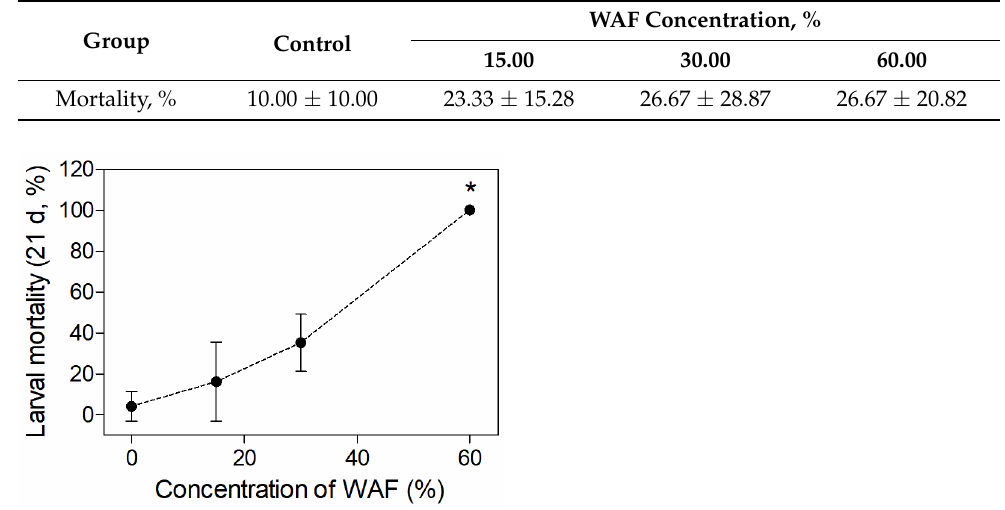
Figure 2. Mortality of marine medaka larvae after 21 d of exposure in chronic test ( n = 3). The symbol * indicates significant difference of the treatment compared to the control ( p < 0.05).